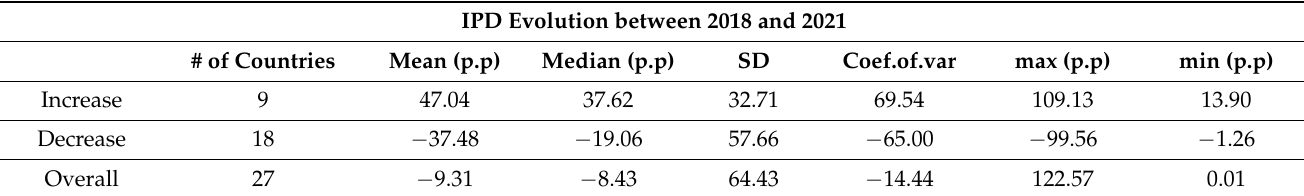
Table 6. Hypothesis tests on the direction of change of IPDs between 2018 and 2021.